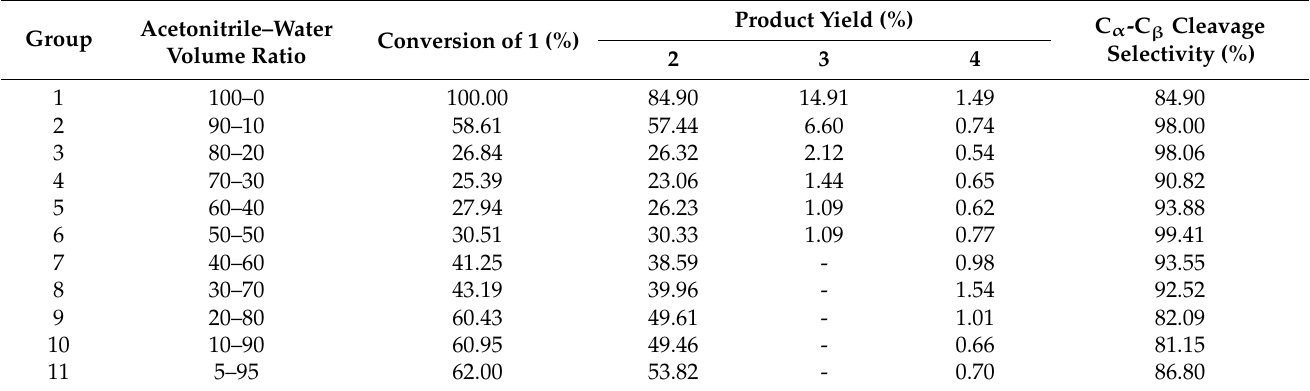
different volume